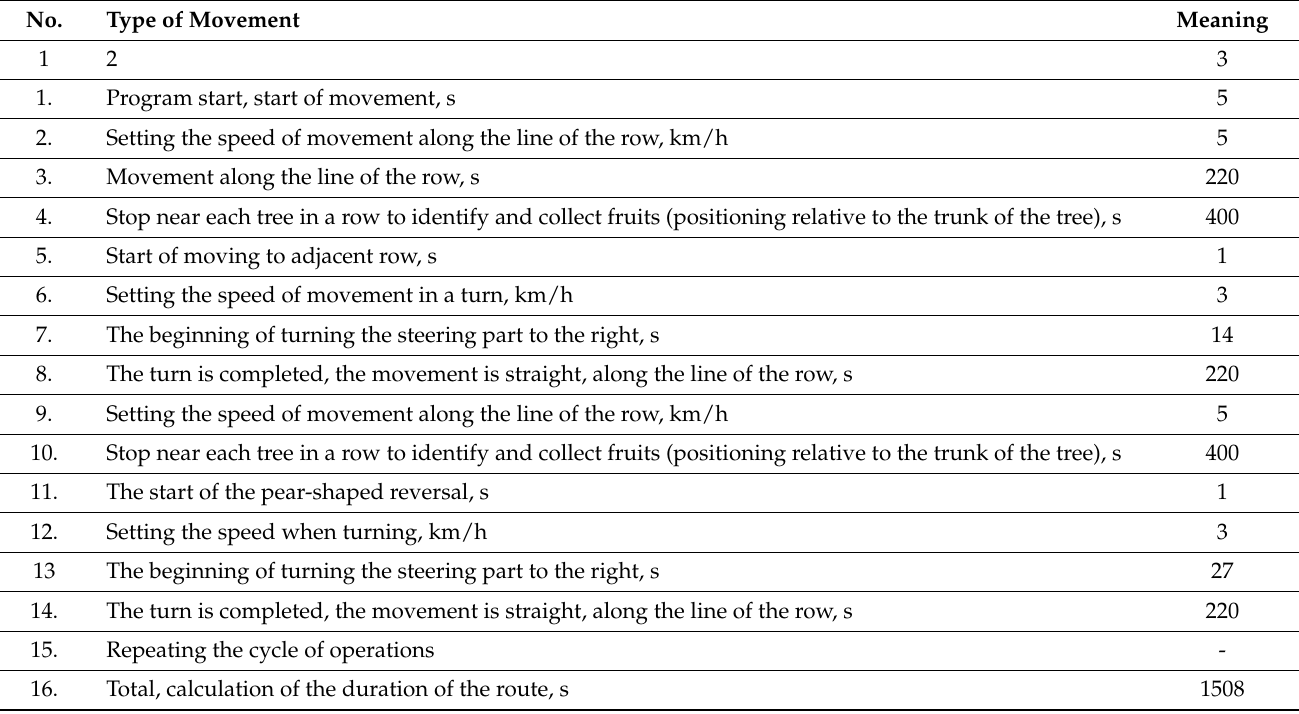
Table 1. Chronology of the route “Apple fruit harvesting with shuttle mode of movement through a row, with a pear-shaped turn”.